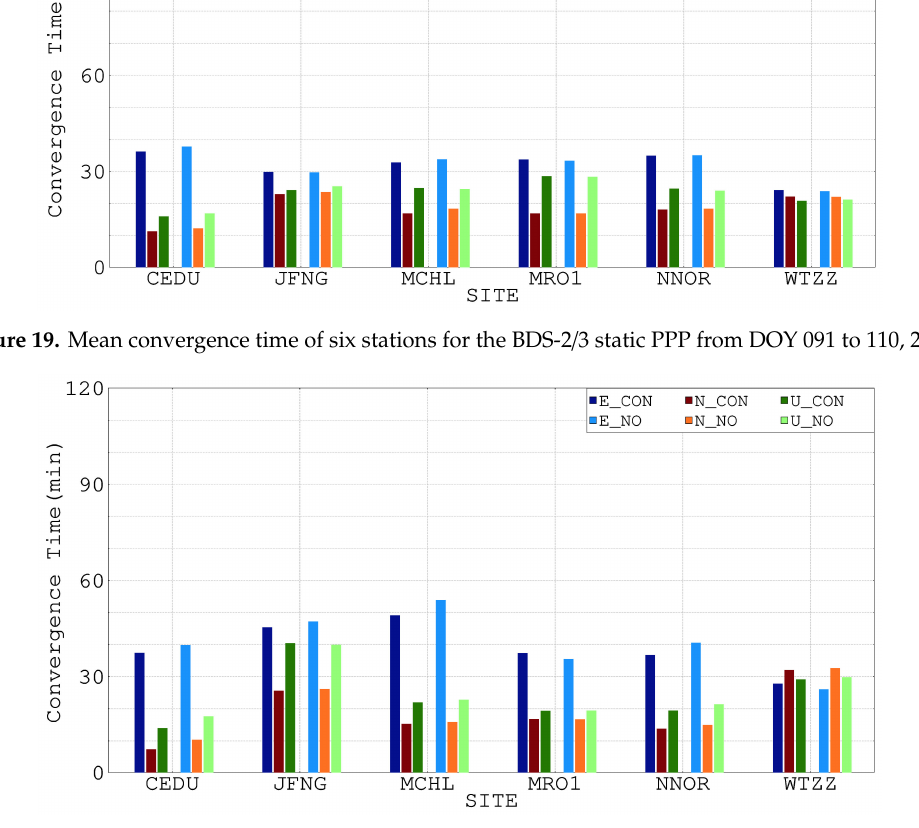
Figure 20. Mean convergence time of six stations for the BDS-2 / 3 kinematic PPP from DOY 091 to 110, 2020. Table 4. RMS (unit—cm) of static PPP solutions under the ISB_CON and ISB_NO schemes at di ff erent convergence epochs of 15 min, 30 min, 1 h, 2 h and 6 h, from DOY 091 to 110,